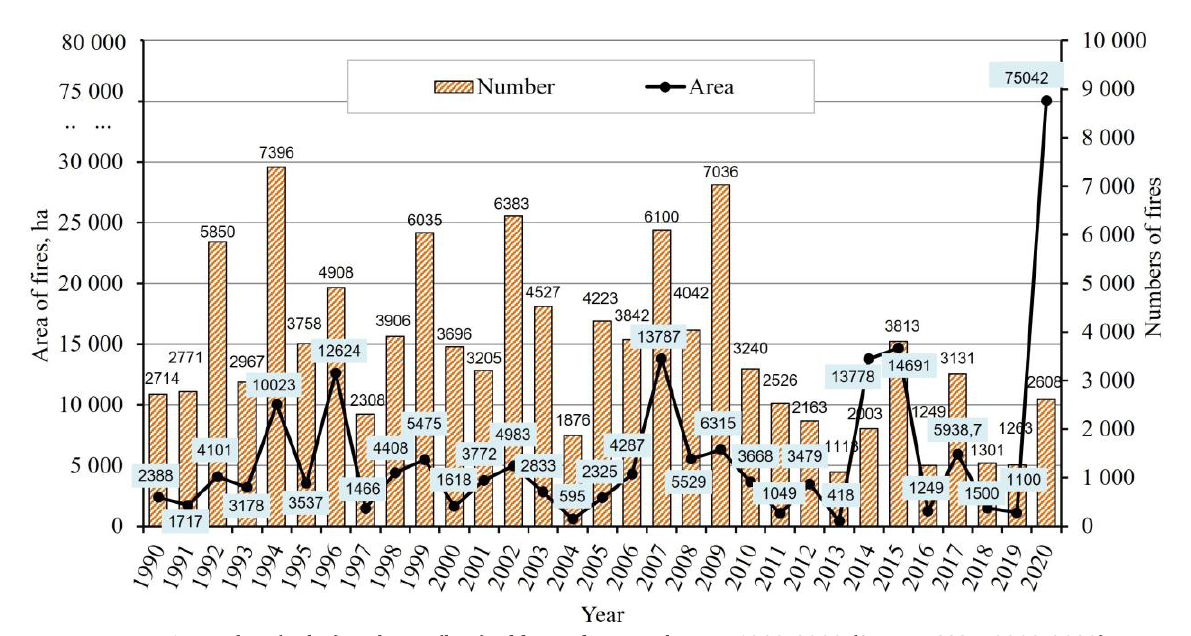
Fig. 1. Number (poles) and area (line) of forest fires in Ukraine, 1990-2020 (Source: SSSU,